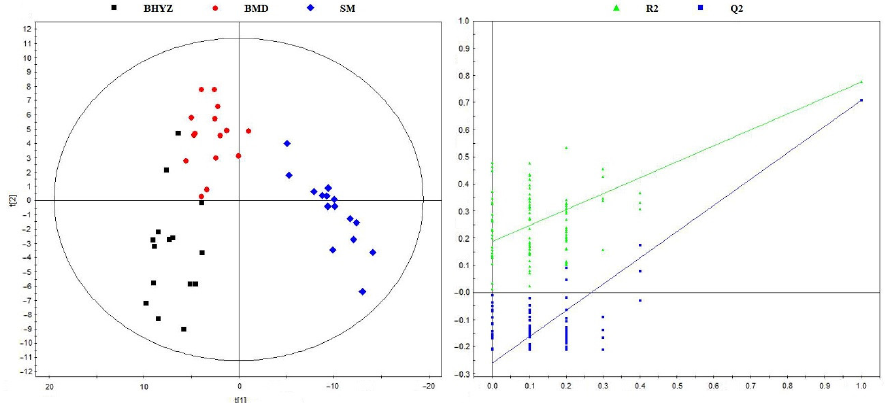
Figure 2. a) The partial least squares discrimination analysis (PLS-DA) score plot (R 2 X = 0.637, R 2 Y = 0.958, Q 2 = 0.855); b) : cross-validation plot of the PLS-DA model with 100 permutation tests (R 2 = 0.186, Q 2 = − 0.262).